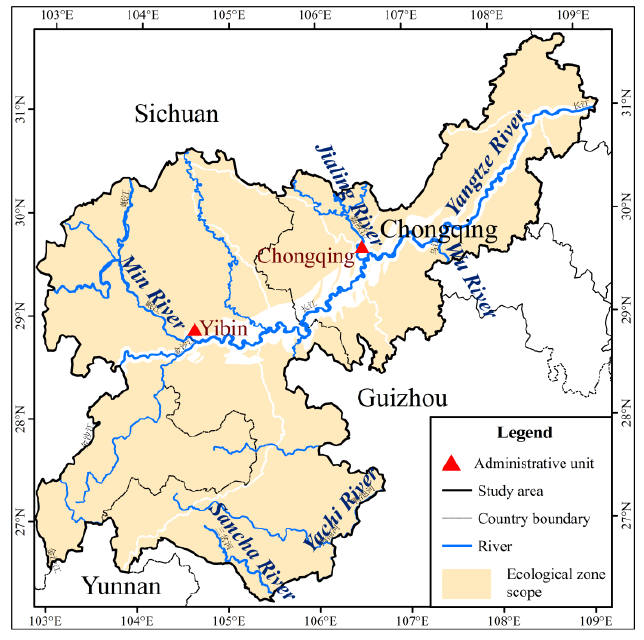
Figure 6. The scope of ESZR .